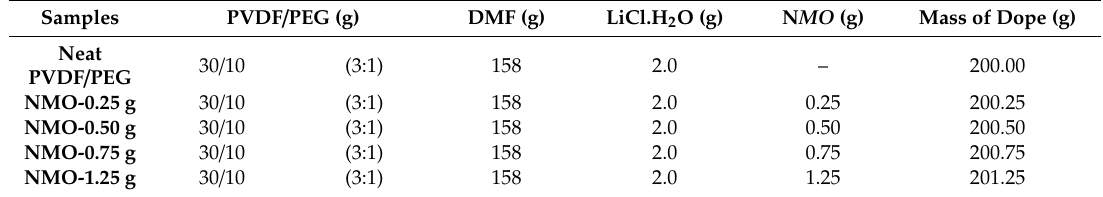
Table 1. Chemical formulation of Neat PVDF-PEG and modified Nano-hybrid